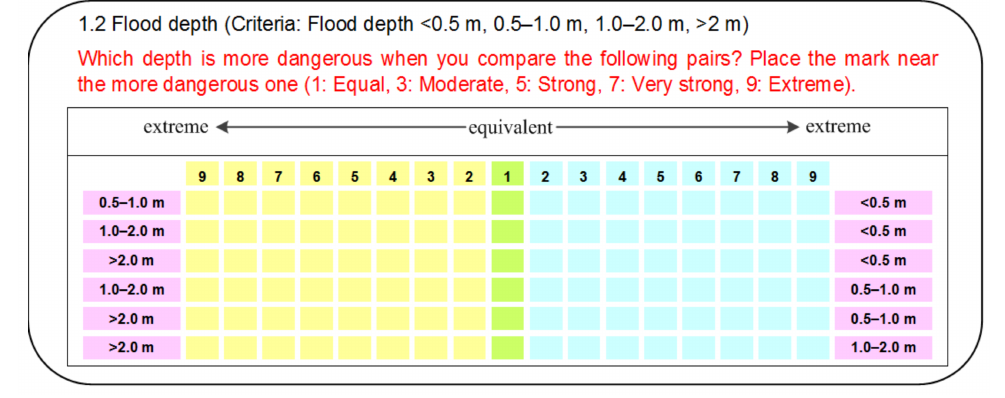
Figure 4. An example of Analytic Hierarchy Process (AHP) pairwise